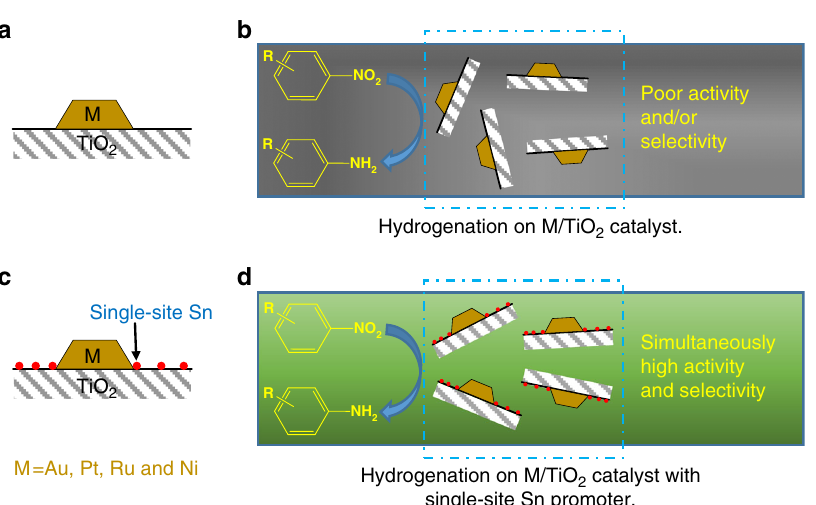
Fig. 2 Model of catalysts with and without single-site Sn promotion. a Conventional M/TiO 2 catalysts; b M/TiO 2 catalysts in hydrogenation of substituted nitroarenes, for which poor activity or selectivity was obtained; c M/TiO 2 catalysts with single-site Sn promoters; d M/TiO 2 catalysts in hydrogenation of substituted nitroarenes, for which simultaneously high activity and selectivity were achieved by single-site Sn